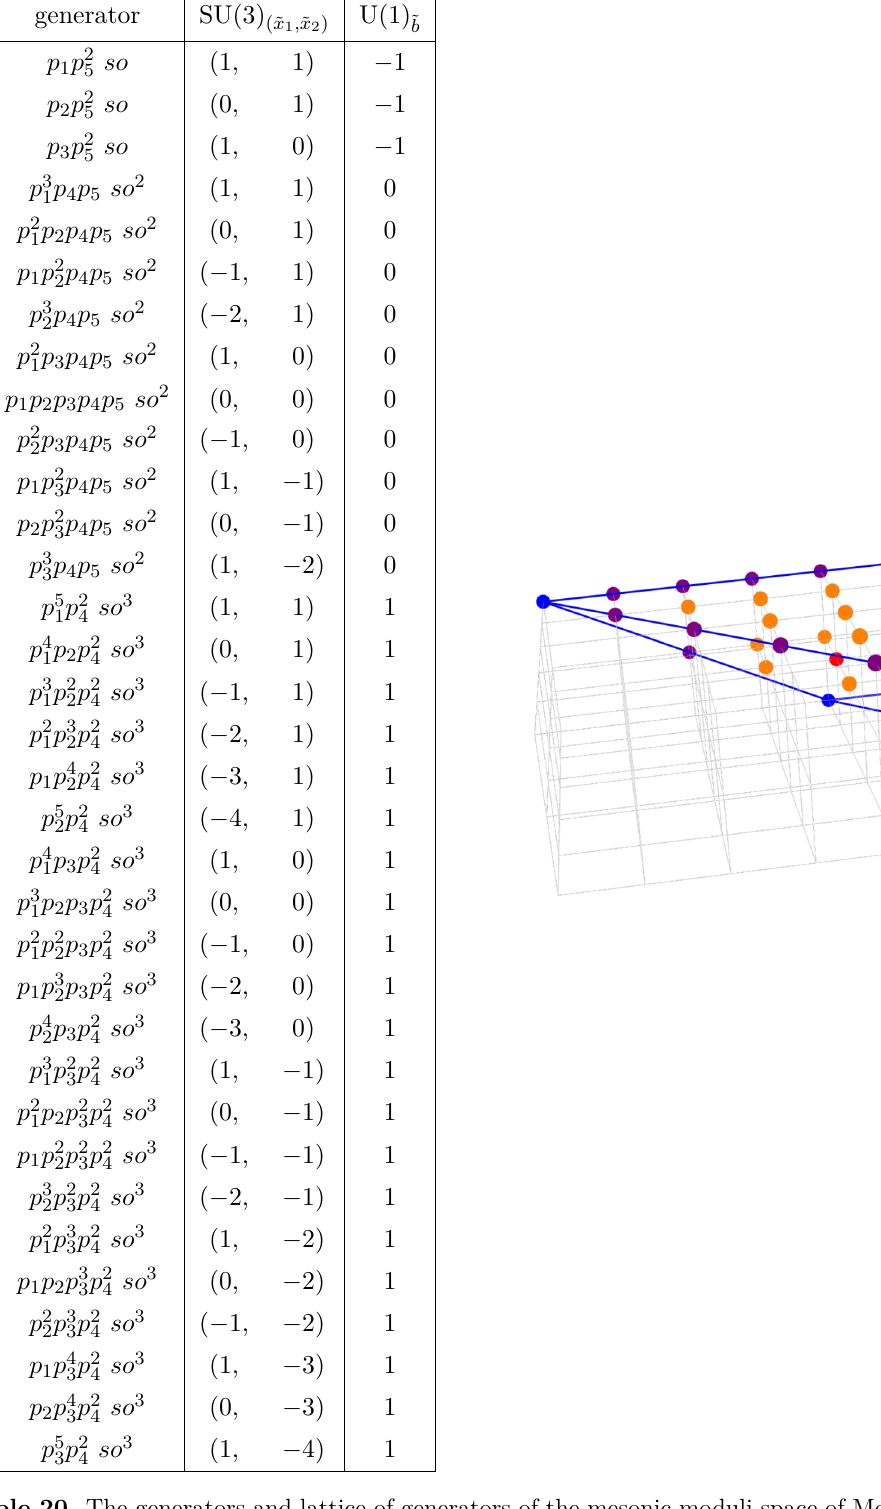
Table 20 . The generators and lattice of generators of the mesonic moduli space of Model 5 in terms of brick matchings with the corresponding flavor